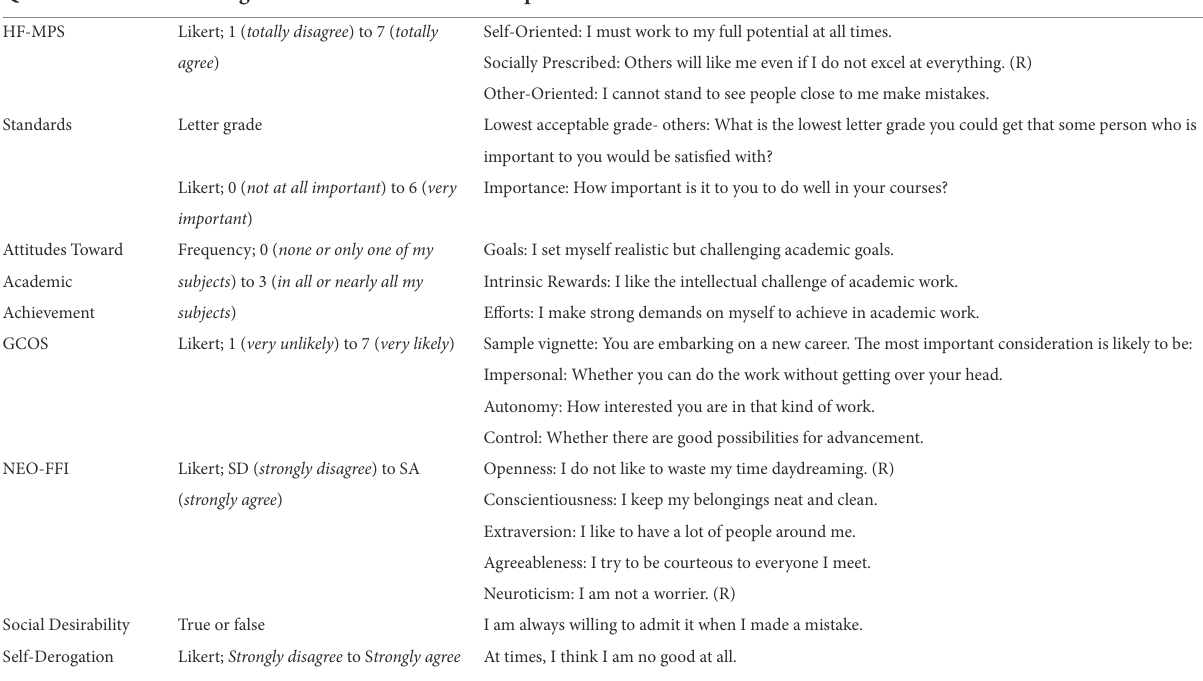
TABLE 3 Questionnaires characteristics, Study